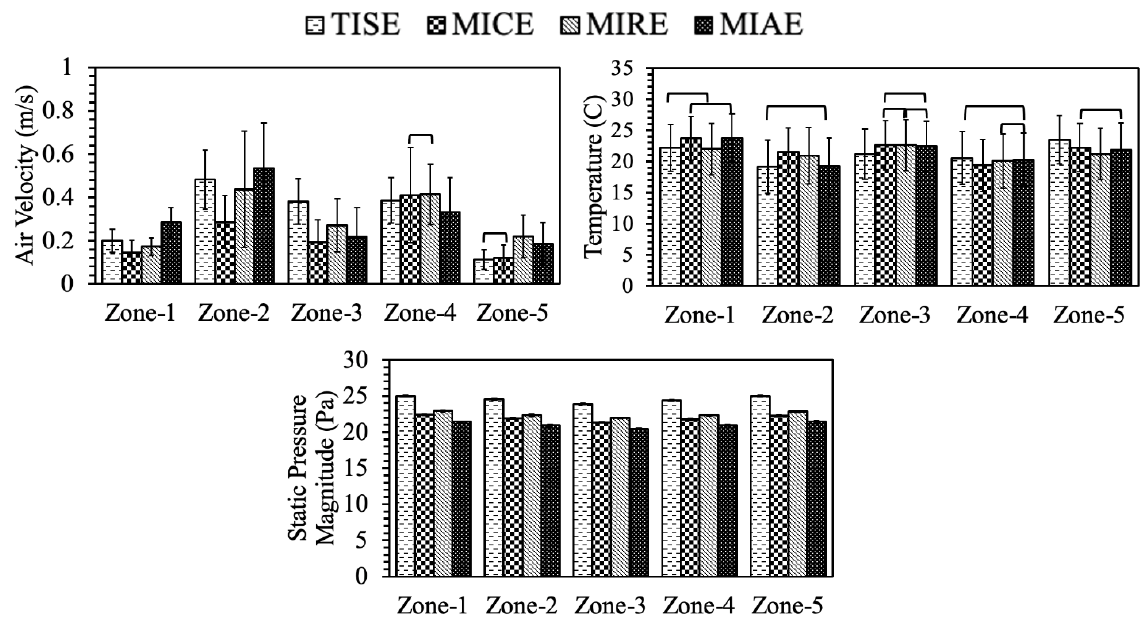
Figure 12. Environmental parameters of hen-occupied zones at Plane N in four models. Crossbars indicate no statistically significant differences at 95% family-wise confidence level. Error bars stand for the standard deviation.